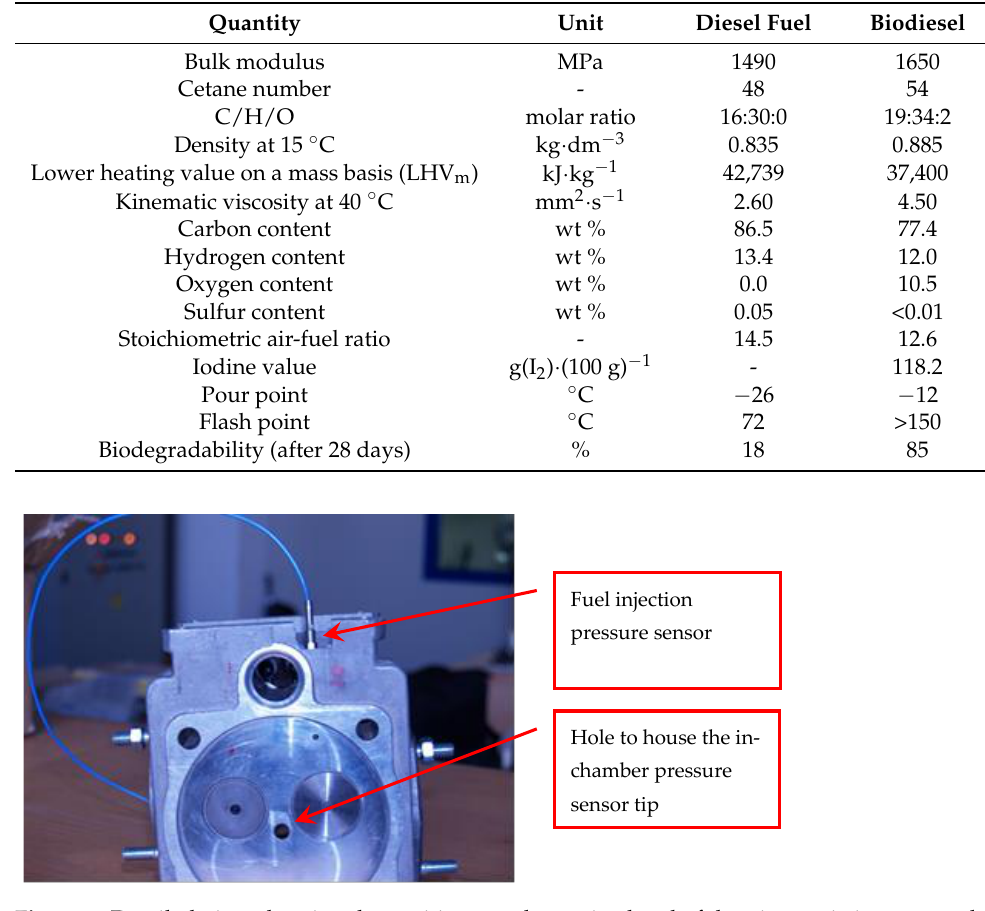
Figure 2. Detailed view showing the positions on the engine head of the piezoresistive sensors by AVL used to measure the pressure in the combustion chamber and in the fuel injection subsystem. Table 3. Main specifications about the measuring instruments used in the test campaign.